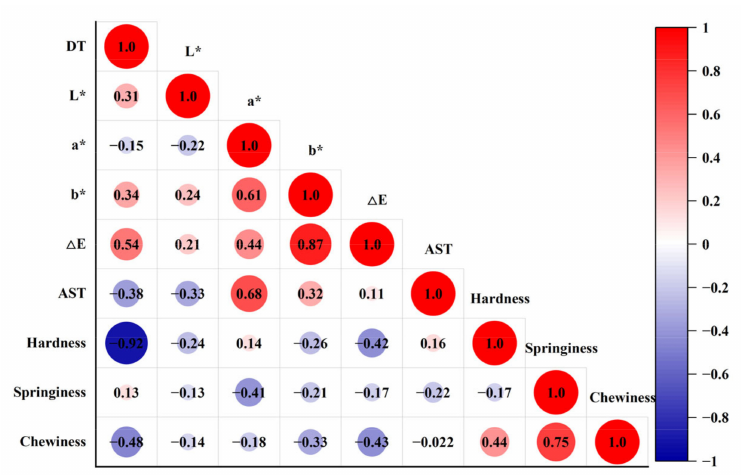
Figure 4. Correlation matrixes between the determination parameters. DT: drying time; AST: